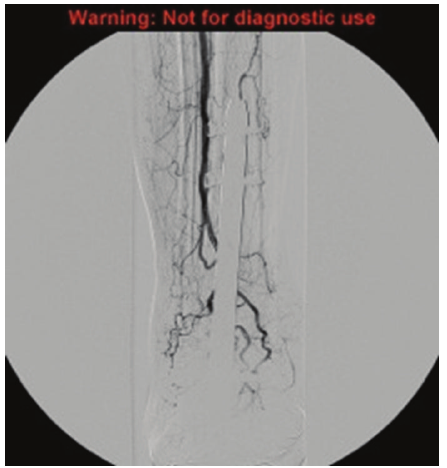
Figure 2: Angiography demonstrating a pseudoaneurysm of the anterior tibial artery.